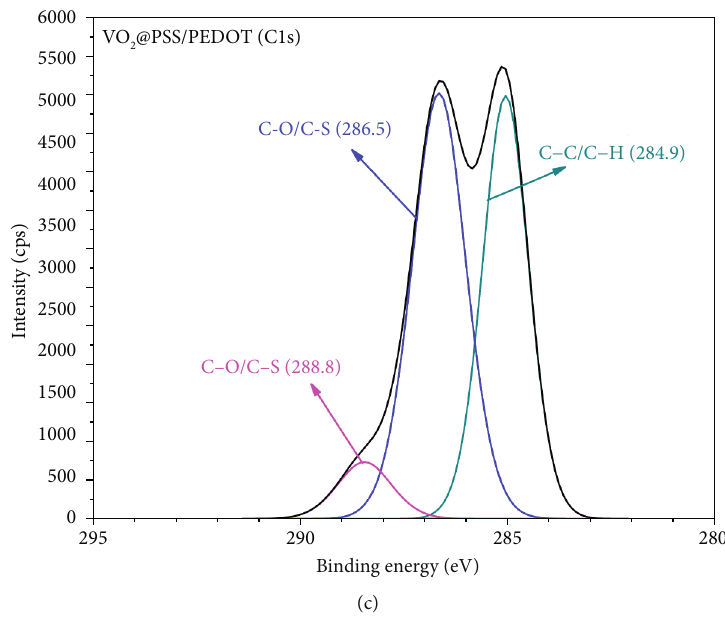
Figure 4: Peak fi tting of C 1s of (a) VO